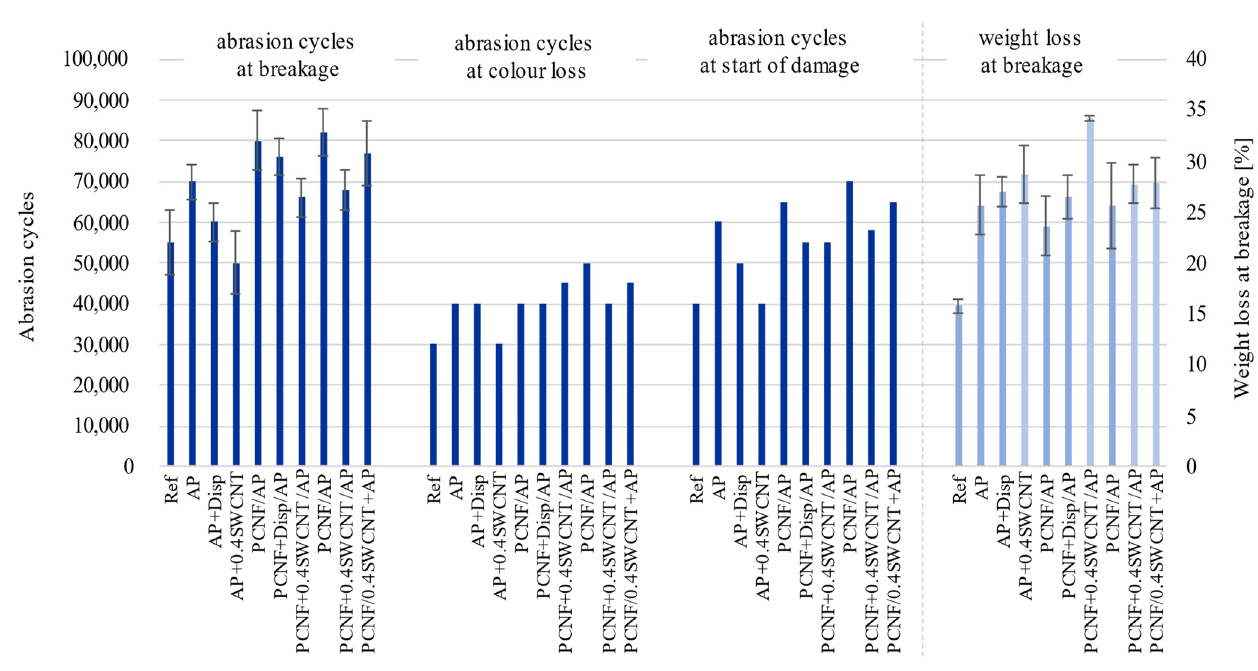
Figure 10. The effect of printing on the fabric’s abrasion resistance and weight loss properties.